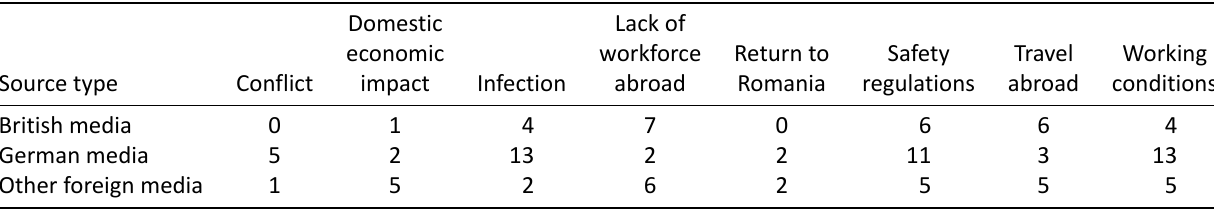
Table 3. Co‐occurrence of topics with foreign media